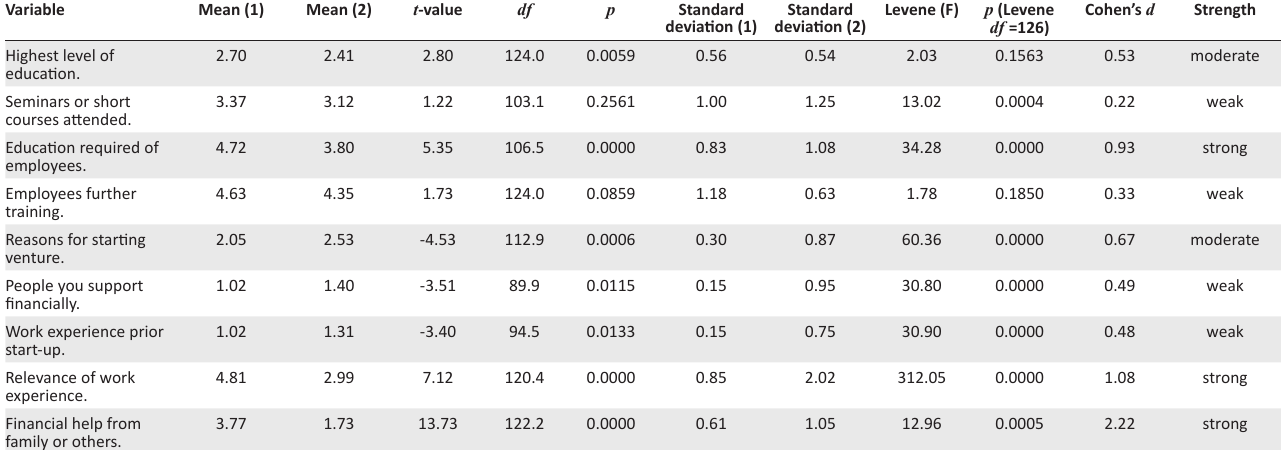
Standard Levene (F) p (Levene Cohen’s d Strength deviation (1) deviation (2) df =126) weak